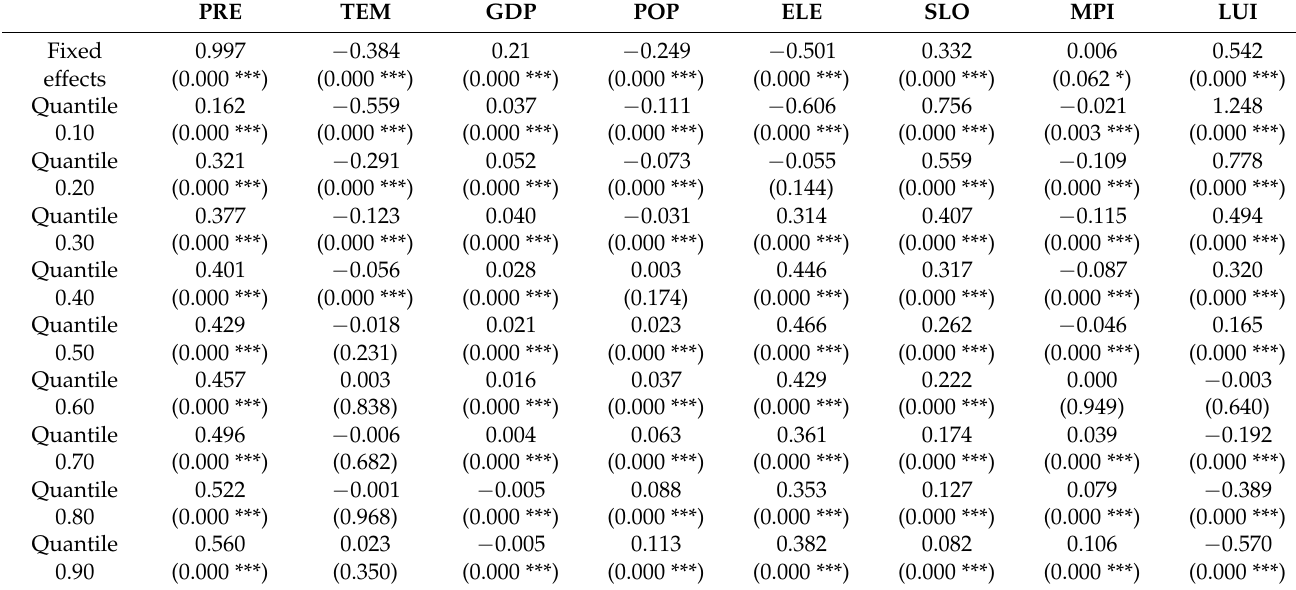
Table 6. The regression results of SPQR of influencing factors under different